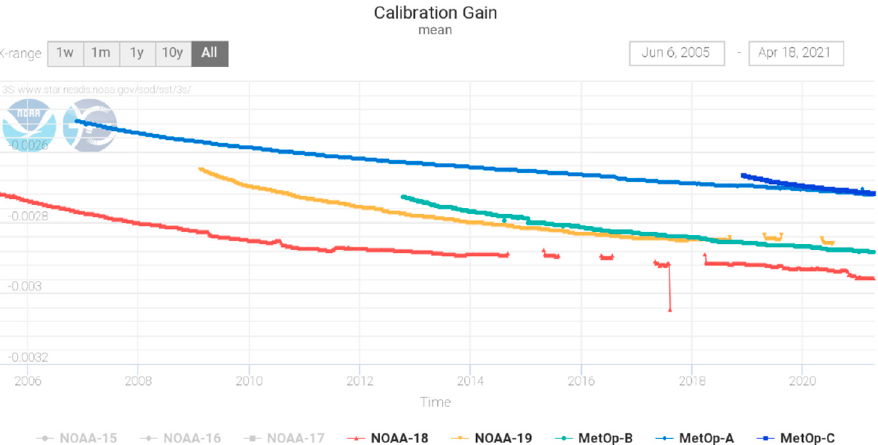
Figure 3. Orbital average (over nighttime part of the orbit) calibration gains in AVHRR/3 channel 3B for Metop-A/B/C and NOAA-18/19. (From the NOAA Sensor Stability for SST, 3S system [37,38] ).